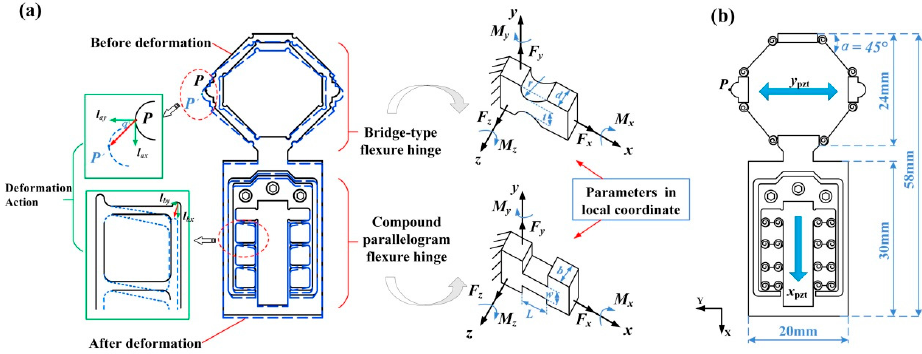
Figure 2. The designed flexure hinge: ( a ) structure; and ( b ) linkage model.